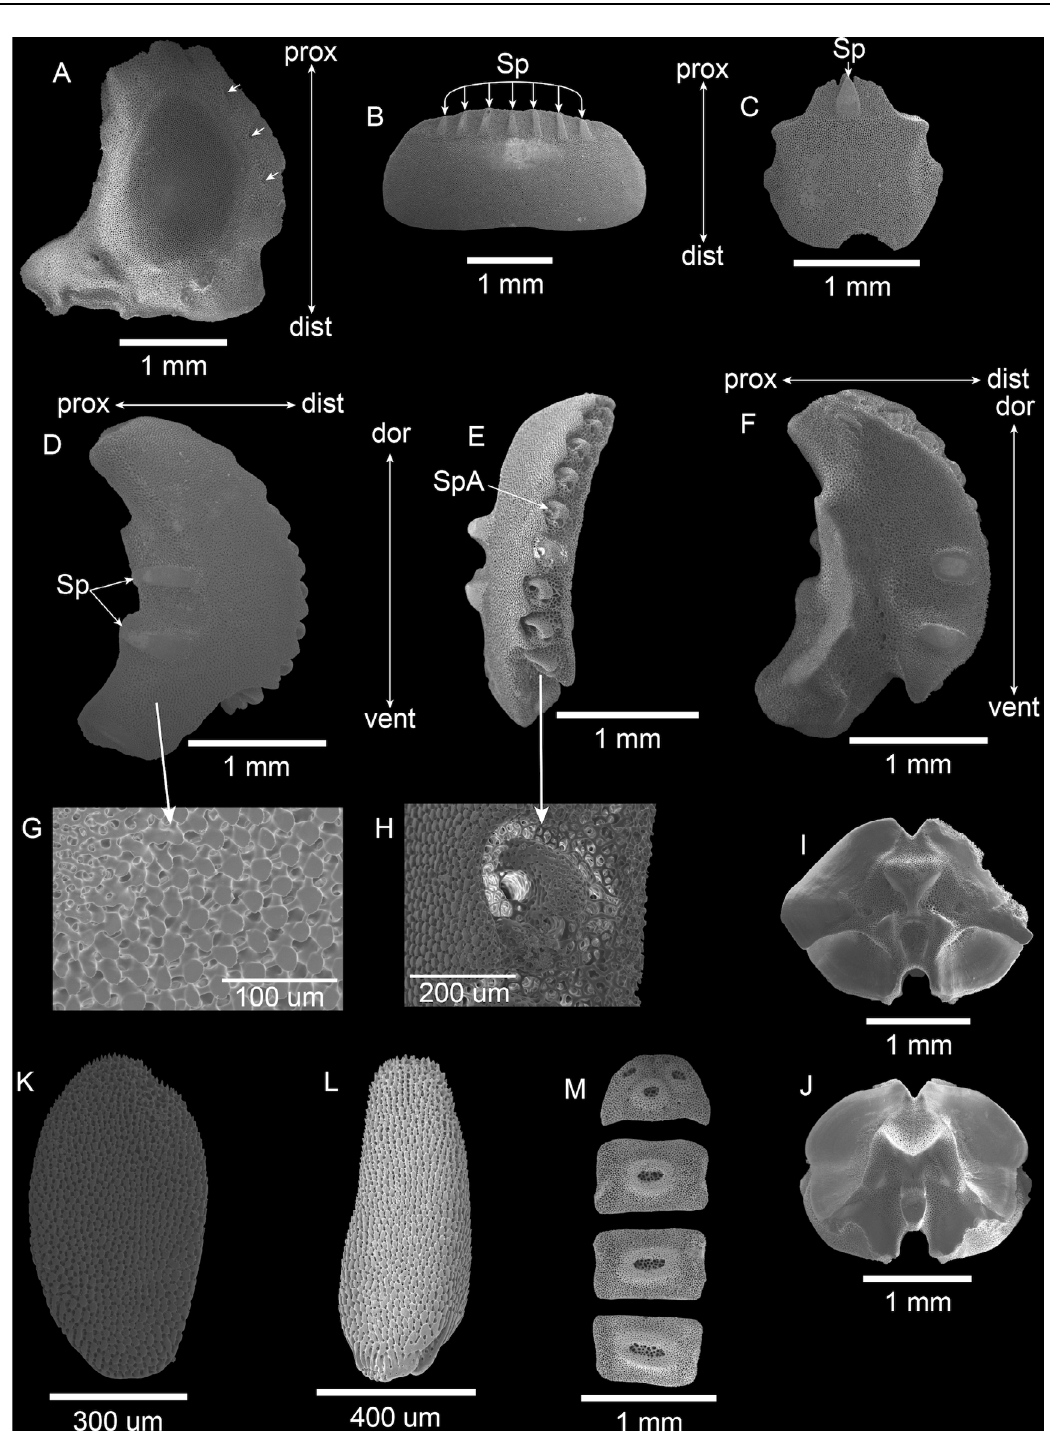
Fig. 6. SEM images of skeletal elements of Ophioderma panamense (ICML-UNAM 3.18.60, DD = 11.1 mm). A . Radial shield (external view), the pores marked with arrows. B . Dorsal arm plate, with seven spurs. C . Ventral arm plate with one spur. D . Lateral arm plate, external face, with two spurs. E . Lateral arm plate, lateral face, with spine articulations. F . Lateral arm plate, internal face. G . Outer surface of the LAP (D) with fine mesh and rounded knobs. H . Spine articulations with a weak sigmoidal fold and tilted lobes. I . Arm vertebra, proximal face. J . Arm vertebra, distal face. K . Tentacle scale. L . Arm spine. M . Dental plate